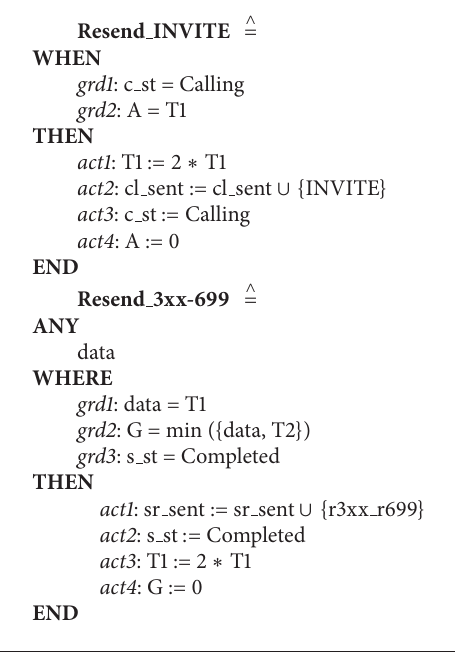
Algorithm 4: Events of third refienement.